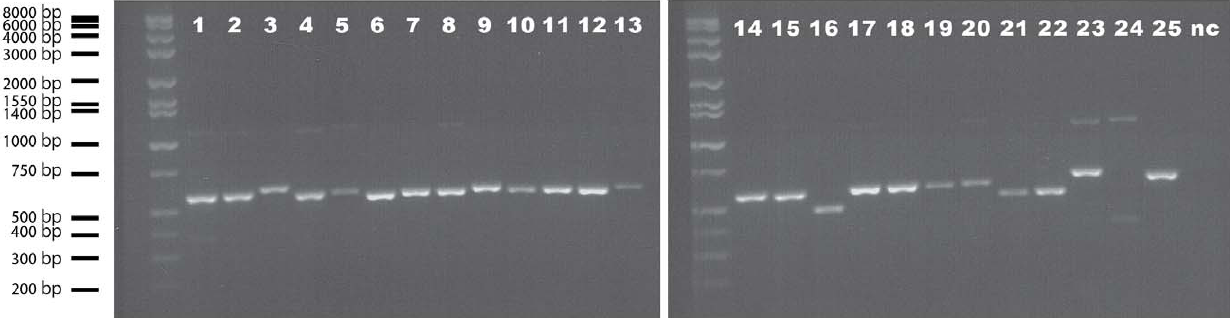
Figure 3. Agarose gel images of the compatibility test using PCR. The newly designed primers were used in PCR reactions for individuals belonging to various groups within six phyla: Sipuncula- 1 Phascolosoma sp.; Echinodermata- 2 Ophiocoma erinaceus (brittlestar); Chordata- 3 Pseudamiops gracilicauda (fish); Annelida (Polychaeta)- 4 Pherecardia striata , 5 unidentified terebellid species; Arthropoda- 6 Xanthias latifrons (brachyuran crab), 7 Pilodius flavus (brachyuran crab), 8 Liomera sp. (brachyuran crab), 9 Carupa sp. (brachyuran crab), 10 unidentified pilumnid species (brachyuran crab), 11 unidentified xanthid species (brachyuran crab), 12 Calcinus gouti (anomuran crab), 13 Synalpheus sp. (caridean shrimp), 14 Periclimenes sp. (caridean shrimp), 15 unidentified caridean shrimp, 16 unidentified amphipod species; Mollusca- 17 Cypraea helvola (gastropod), 18 Cypraea fimbriata (gastropod), 19 Trivia sp. (gastropod), 20 Erato sandwichensis (gastropod), 21 unidentified haminoeid species (gastropod), 22 Berthellina sp. (gastropod), 23 Chlamys sp. (bivalve), 24 Lima sp. (bivalve), 25 unidentified lucinid species (bivalve). nc-negative control. Good amplifications were observed for all individuals except one bivalve (24).